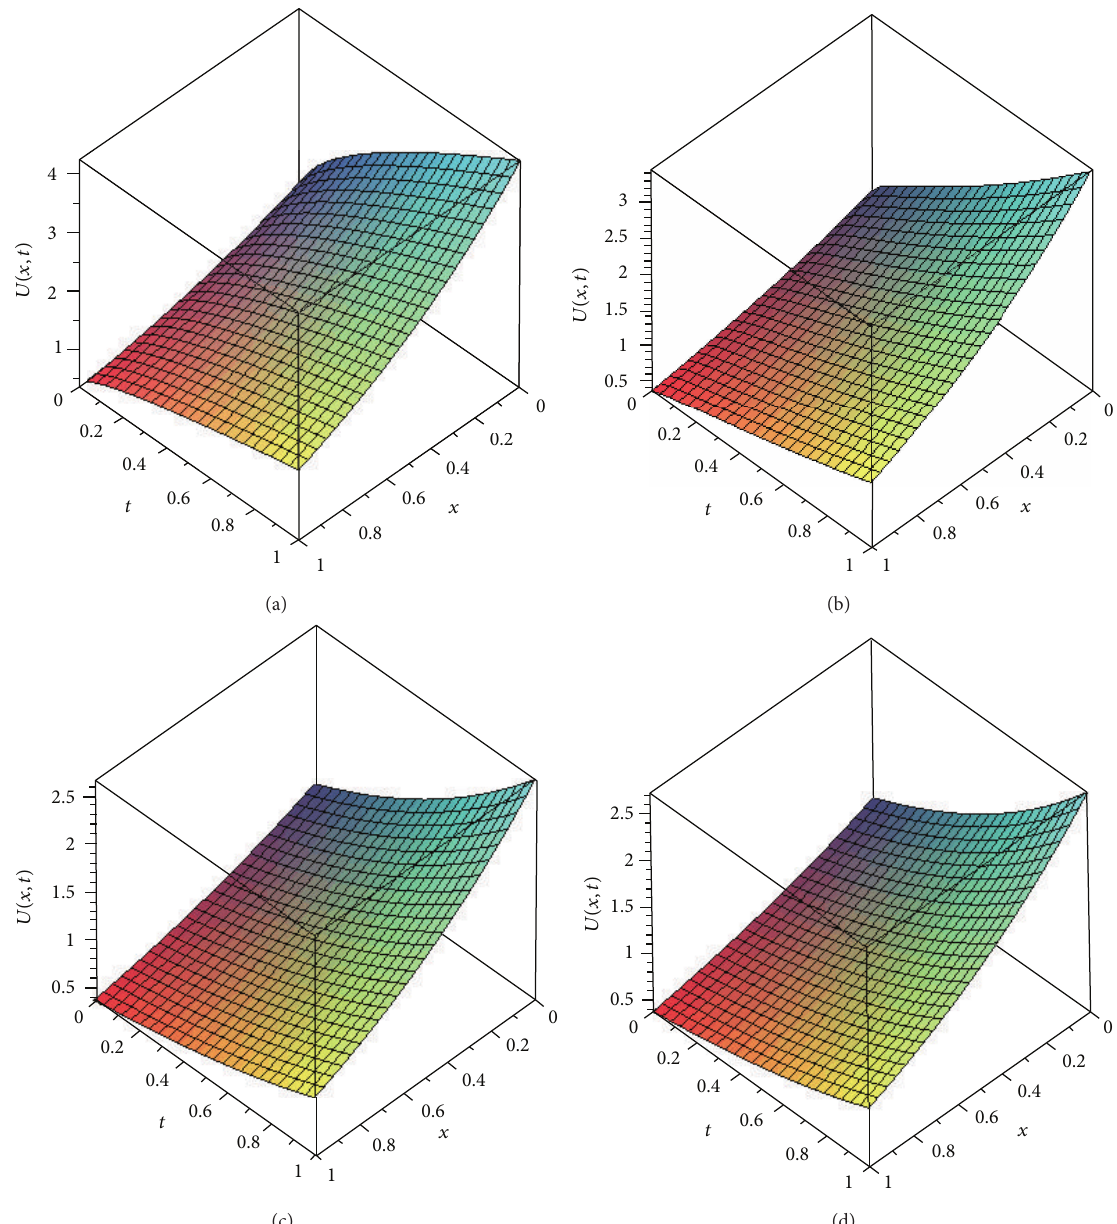
Figure 1: The behaviour of the 𝑈(𝑥,𝑡) w.r.t. 𝑥 and 𝑡 are obtained when (a) 𝛼 = 1/3 , (b) 𝛼 = 2/3 , (c) 𝛼 = 1 , and (d) exact